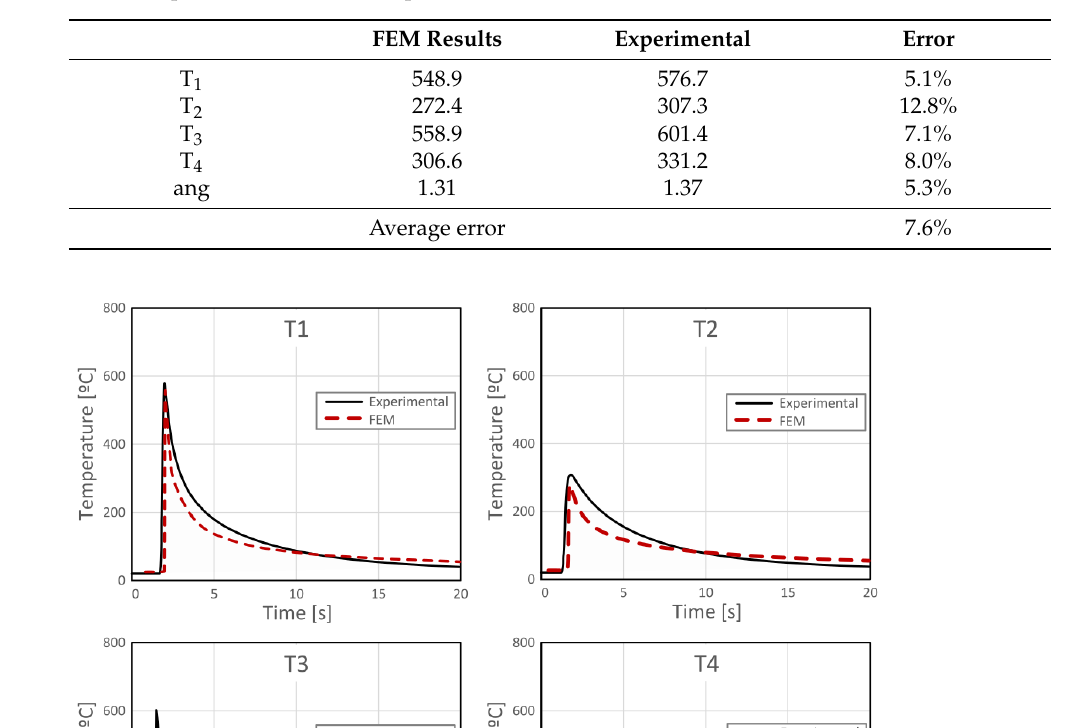
Table 8. Optimization results comparison.